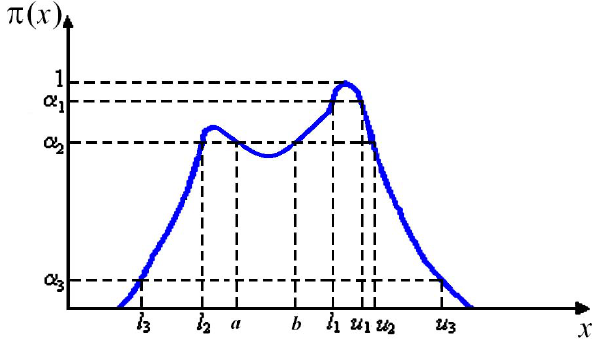
Fig. 1. Example of a normal possibility distribution with two local